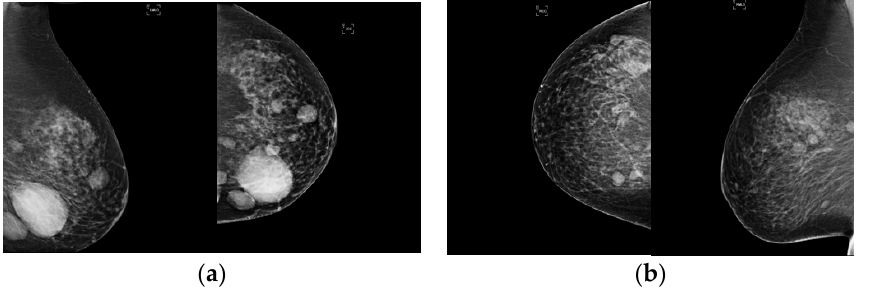
Figure 1. A 40-year-old woman with multiple tumor formations of both breasts on mammography. ( a ) Mammography left breast— Mediolateral oblique view (MLO) and craniocaudal (CC). ( b ) Mammography right breast—MLO and CC.